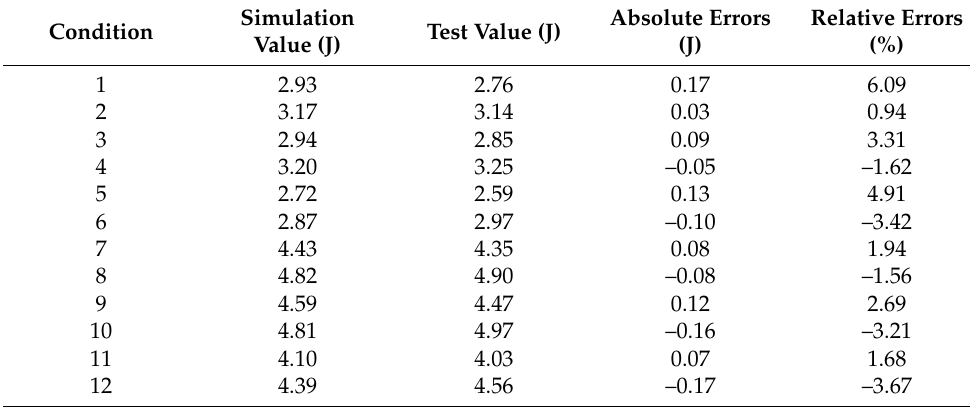
Table 9. The validation of electric energy